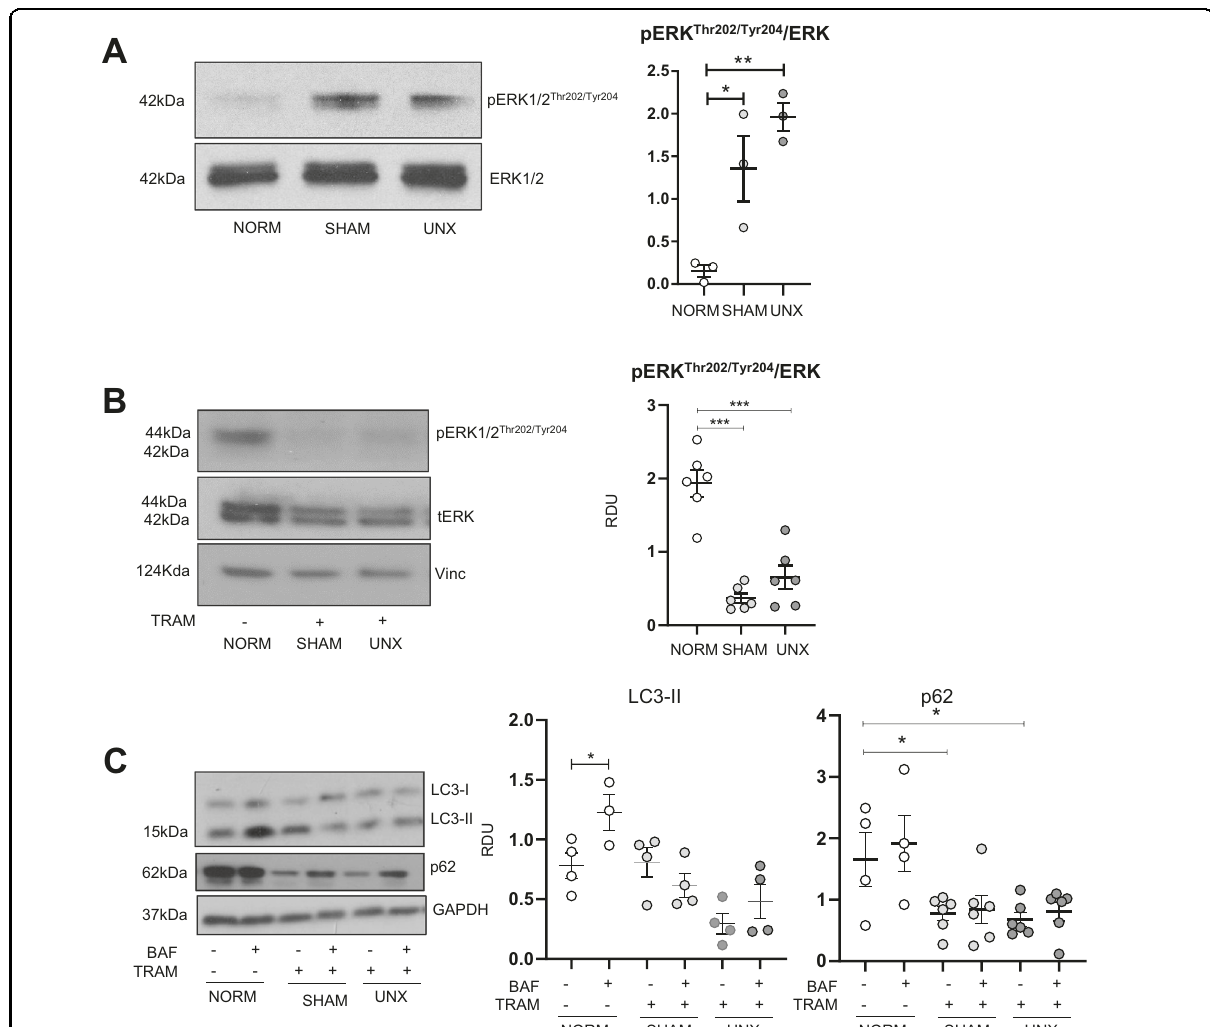
Fig. 7 ERK1/2 inhibition attenuates increased p62 seen after sham surgery and UNX. Mice were treated with either Trametinib (1 mg/kg/d IP) or vehicle (3% DMSO in saline) for 3 days. Mice then underwent either no surgical manipulations (NORM), sham surgery (SHAM), or unilateral nephrectomy (UNX). Each mouse was treated with either vehicle (VEH) or BafA1 (BAF) and after 2 h the contralateral kidney was harvested. A pERK1/2 was signi fi cantly increased in sham surgery and UNX vs. normal kidneys. B Trametinib resulted in a near disappearance of pERK1/2 in sham surgery and UNX kidneys. C Trametinib resulted in a signi fi cant decrease in p62 in sham surgery and UNX kidneys compared to normal kidneys, but did not change the suppressed autophagic fl ux that was seen in sham surgery and UNX kidneys. Immunoblot analysis of LC3-II and p62 in the kidney with representative densitometry is demonstrated. RDU = relative densitometry units corrected for GAPDH. * P < 0.05, ** P < 0.01, *** P <